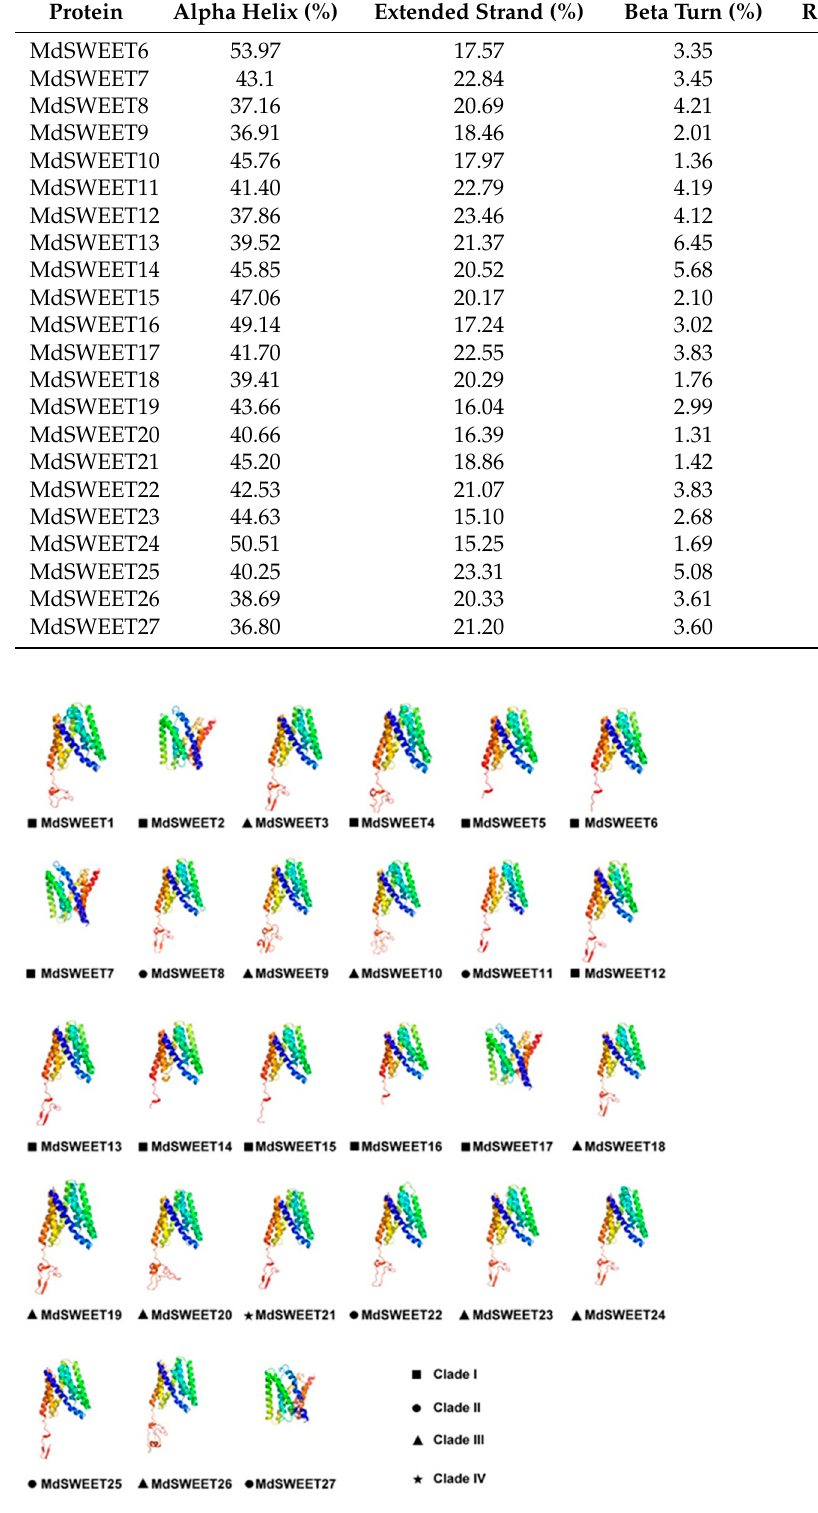
Figure 3. Three-dimensional models of MdSWEET proteins. The 3D model structures of the MdSWEET proteins were predicted using Protein Homology/Analogy Recognition Engine V 2.0. The square, circle, triangle, and star at the left of each protein name represent clade I, II, III, and IV,